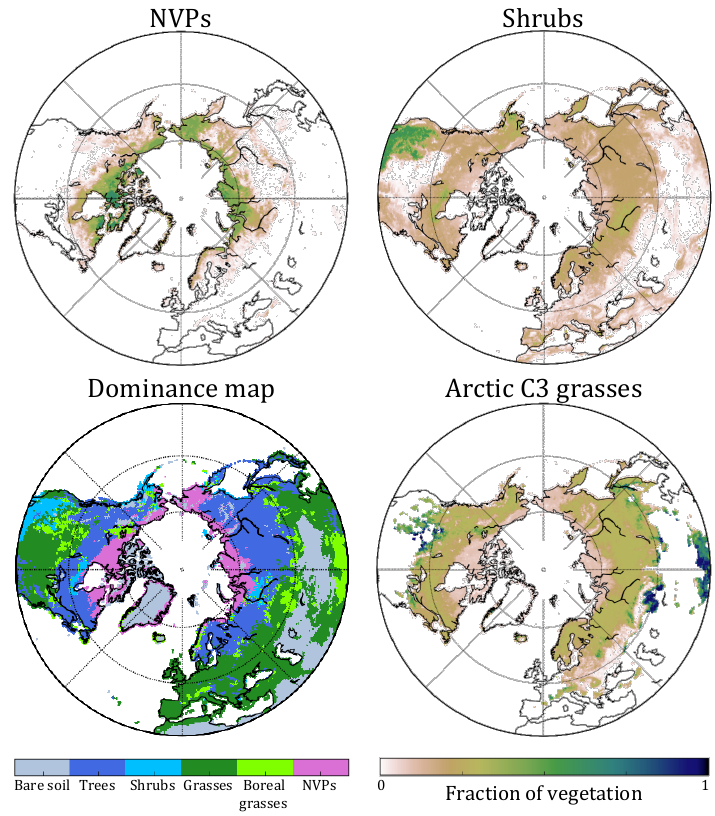
Figure 6. Map of new PFTs’ vegetation coverage and